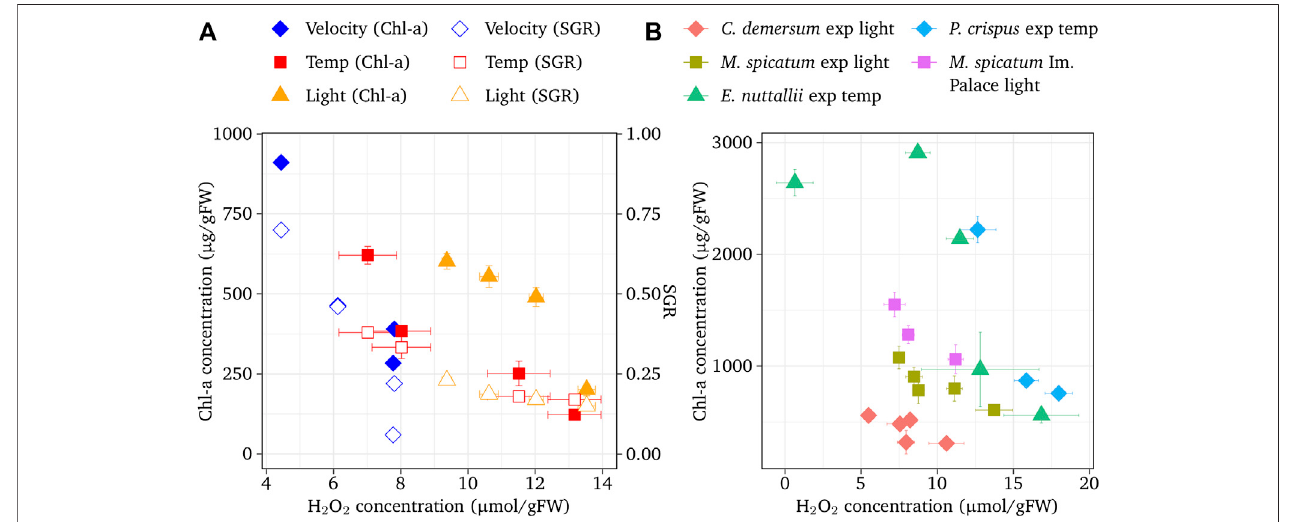
FIGURE 4 | (A) Chlorophyll a concentration and shoot growth rate (SGR) of E. geriadensa with respect to H 2 O 2 concentration. Velocity (Ellawala et al., 2011), others:thepresentexperiment.Verticalbarsindicatestandarddeviation. (B) Chlorophyllisaconcentrationof M.spicatum , C.demersum , E.nuttallii ,and P.crispuss with respect to H 2 O 2 concentration. Vertical bars indicate standard deviation.